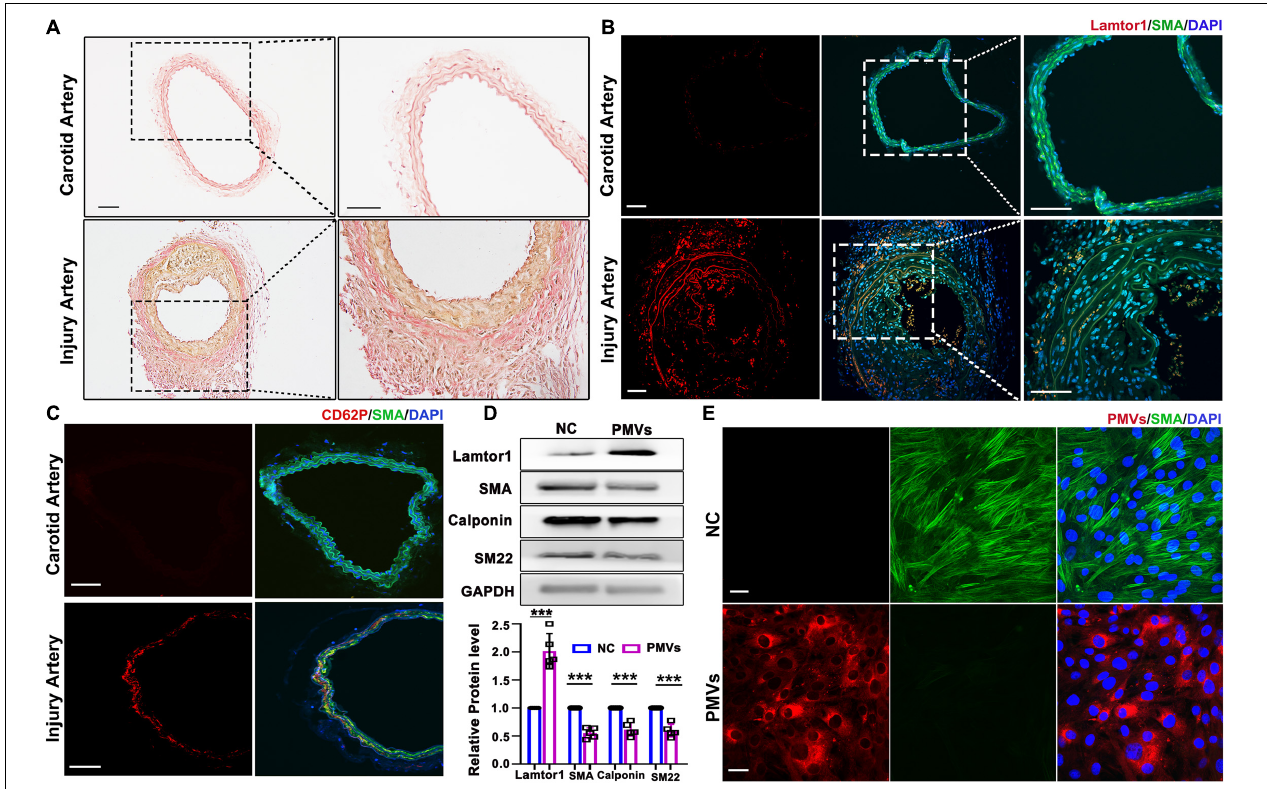
FIGURE 1 | PMVs induced Lamtor1 expression and promoted VSMC dedifferentiation both in vivo and in vitro . (A) Representative images of Elastin Van-Gieson staining showed that the intimal hyperplasia was significantly thickened after 1-week wire injury in mouse model. Scale bars: 100 µ m. (B) Representative images of immunostaining showed that Lamtor1 (red) was expressed in the injured intima after 1-week surgery. Green fluorescence was SMA, nuclei were counterstained with DAPI (blue). Scale bars: 100 µ m. (C) Immunofluorescence staining showed the activated platelet signal labeled with CD62P (red) at the injury site 3 h after intimal injury surgery. Green fluorescence was SMA, nuclei were counterstained with DAPI (blue). Scale bars: 100 µ m. (D) Western blot revealed that Lamtor1 expression was significantly increased and differentiated markers of VSMCs, including SMA, Calponin, and SM22 were decreased after incubating with PMVs for 24 h ( n = 5). Data represent mean ± SD . P < 0.001. (E) Immunofluorescence staining indicated that PMVs (red) markedly decreased the expression of SMA (green) a differentiation marker. Nuclei were counterstained with DAPI (blue). Scale bars: 50 µ